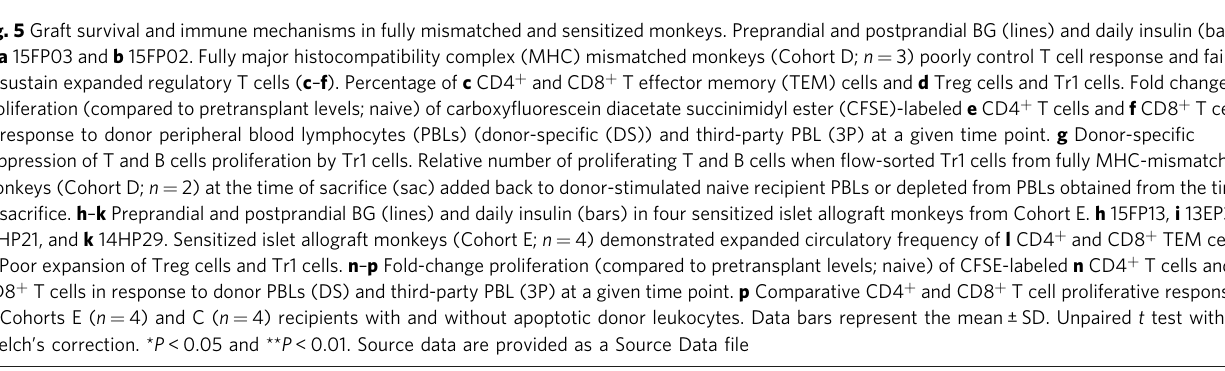
Fig. 5 Graft survival and immune mechanisms in fully mismatched and sensitized monkeys. Preprandial and postprandial BG (lines) and daily insulin (bars) in a 15FP03 and b 15FP02. Fully major histocompatibility complex (MHC) mismatched monkeys (Cohort D; n = 3) poorly control T cell response and failed to sustain expanded regulatory T cells ( c – f ). Percentage of c CD4 + and CD8 + T effector memory (TEM) cells and d Treg cells and Tr1 cells. Fold change in proliferation (compared to pretransplant levels; naive) of carboxy fl uorescein diacetate succinimidyl ester (CFSE)-labeled e CD4 + T cells and f CD8 + T cells in response to donor peripheral blood lymphocytes (PBLs) (donor-speci fi c (DS)) and third-party PBL (3P) at a given time point. g Donor-speci fi c suppression of T and B cells proliferation by Tr1 cells. Relative number of proliferating T and B cells when fl ow-sorted Tr1 cells from fully MHC-mismatched monkeys (Cohort D; n = 2) at the time of sacri fi ce (sac) added back to donor-stimulated naive recipient PBLs or depleted from PBLs obtained from the time of sacri fi ce. h – k Preprandial and postprandial BG (lines) and daily insulin (bars) in four sensitized islet allograft monkeys from Cohort E. h 15FP13, i 13EP3, j 14HP21, and k 14HP29. Sensitized islet allograft monkeys (Cohort E; n = 4) demonstrated expanded circulatory frequency of l CD4 + and CD8 + TEM cells. m Poor expansion of Treg cells and Tr1 cells. n – p Fold-change proliferation (compared to pretransplant levels; naive) of CFSE-labeled n CD4 + T cells and o CD8 + T cells in response to donor PBLs (DS) and third-party PBL (3P) at a given time point. p Comparative CD4 + and CD8 + T cell proliferative responses in Cohorts E ( n = 4) and C ( n = 4) recipients with and without apoptotic donor leukocytes. Data bars represent the mean ± SD. Unpaired t test with Welch ’ s correction. * P < 0.05 and ** P < 0.01. Source data are provided as a Source Data